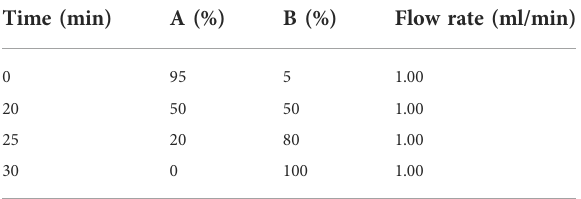
TABLE 1 Optimized gradient for liquid chromatography